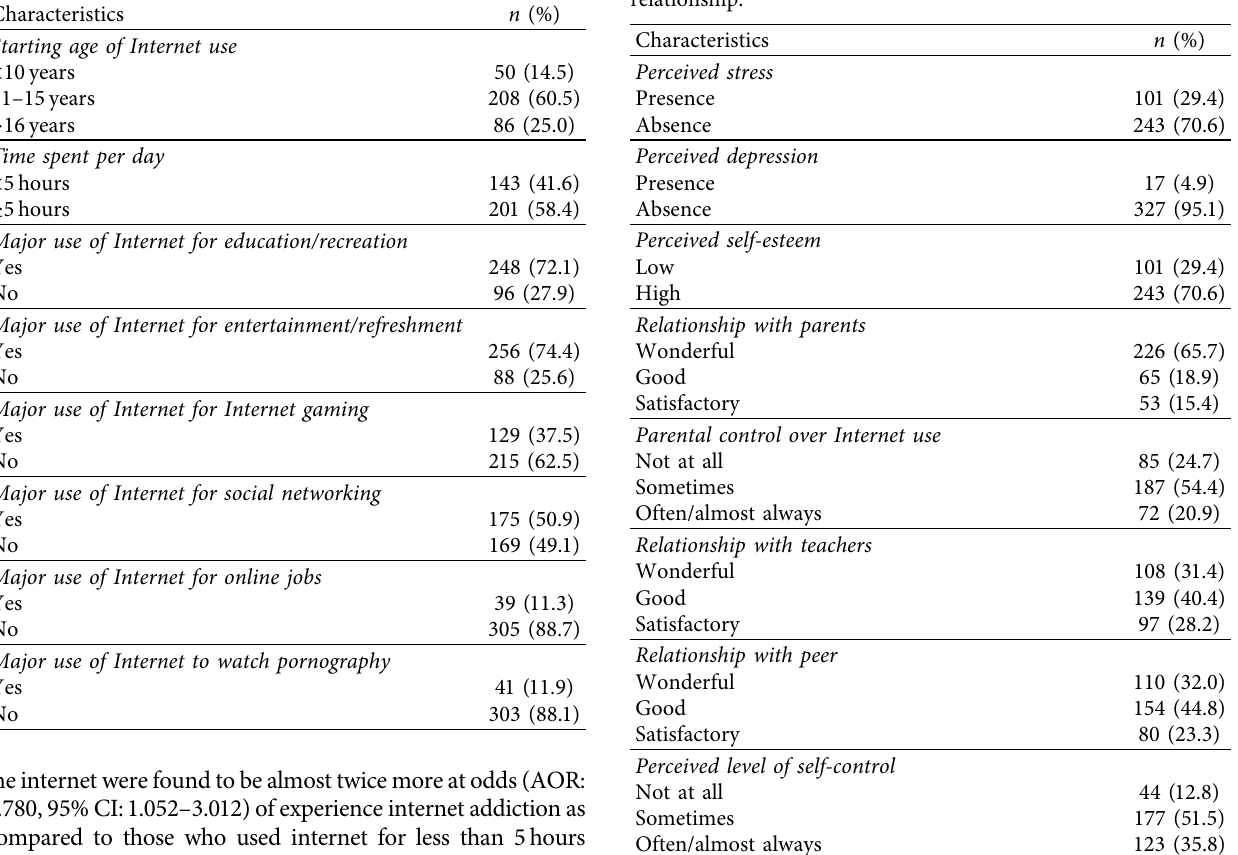
Table 3: Perceived psychological status and interpersonal relationship.